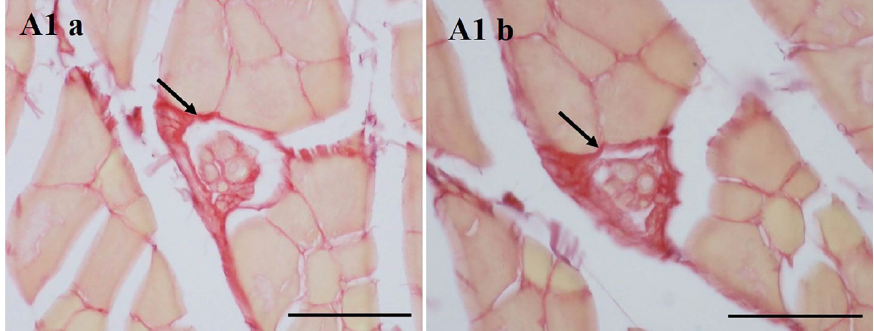
Figure A1. (a:b) MS embedded in the extracellular matrix elements with picrosirius red ( a , b ) of the hindlimb of an 8-month-old mouse (Group B). Scale bar: 50 μ m.